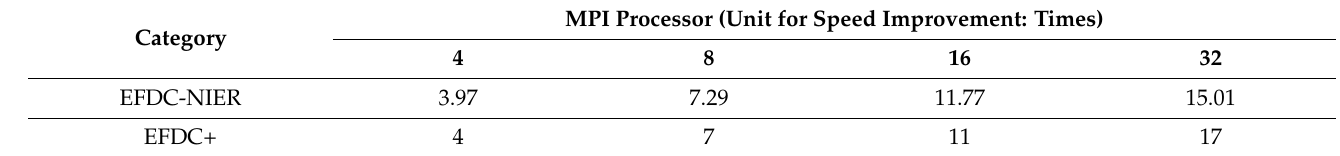
Table B2. Performance improvement in calculation speed by MPI processor.